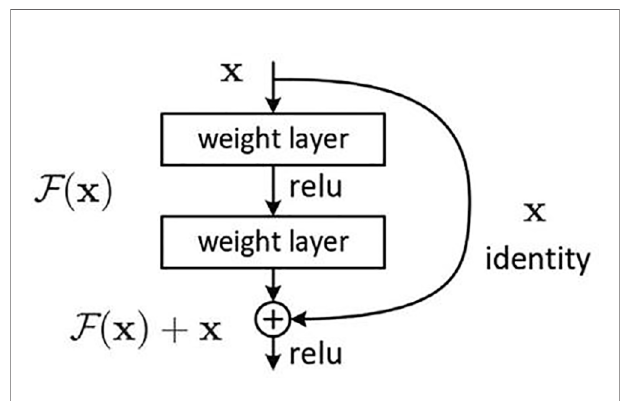
FIGURE 5 | The basic structure of the Resnet.